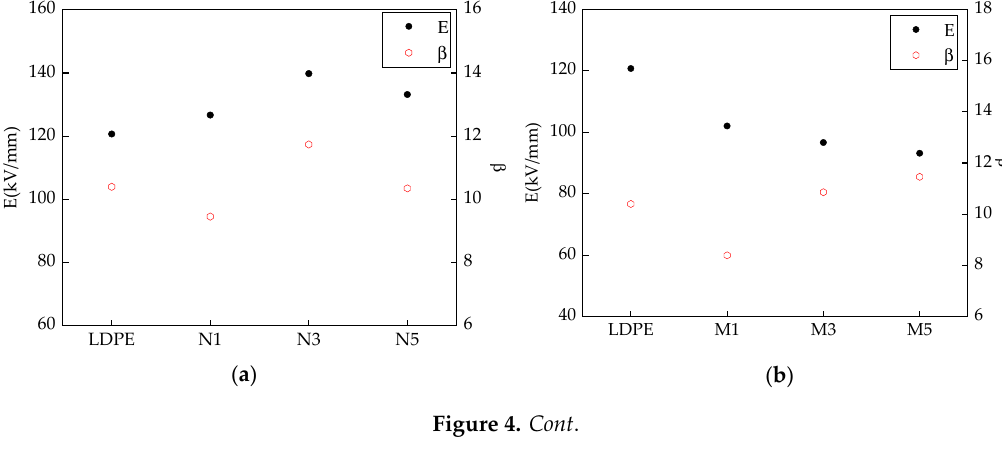
Figure 3. Weibull distribution curves of the micro, nano, and micro-nano ZnO/LDPE composites.